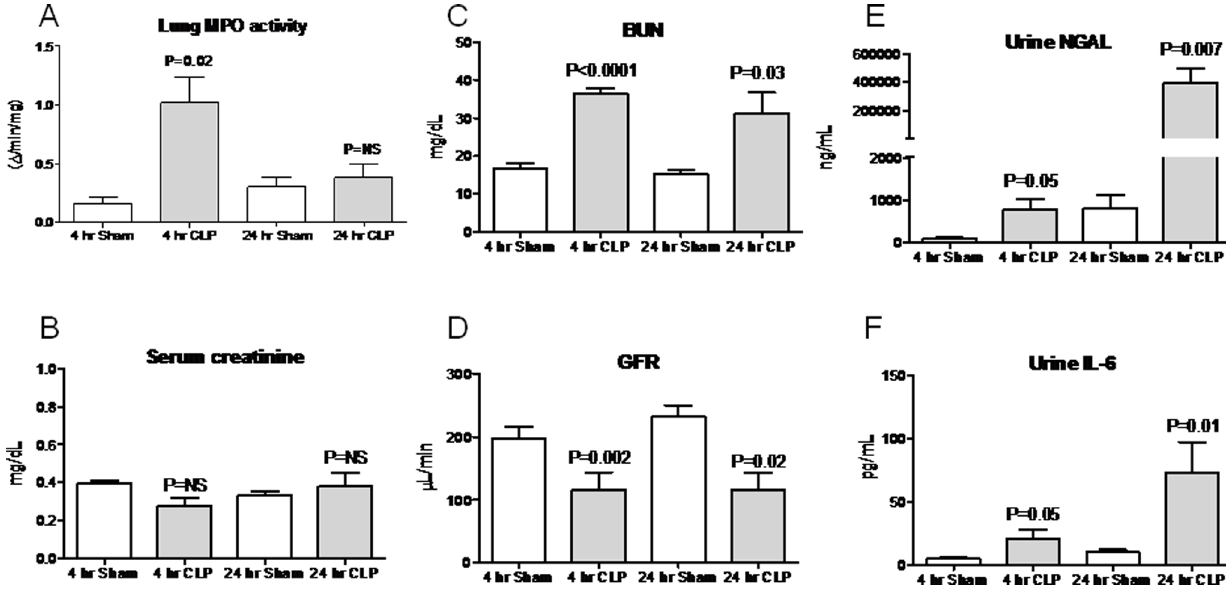
Figure 7. Lung MPO activity, serum creatinine, BUN, glomerular filtration rate (GFR), urine neutrophil gelatinase-associated lipocalin (NGAL), and urine IL-6 BUN 4 and 24 hours after cecal ligation and puncture (CLP). (A) Lung MPO activity, (B) Serum creatinine, (C) BUN, (D) GFR, (E) urine NGAL, and (F) urine IL-6 were determined 4 and 24 hours (hr) after sham operation (Sham) and CLP; n=5–10. P values are versus Sham at the same time point.